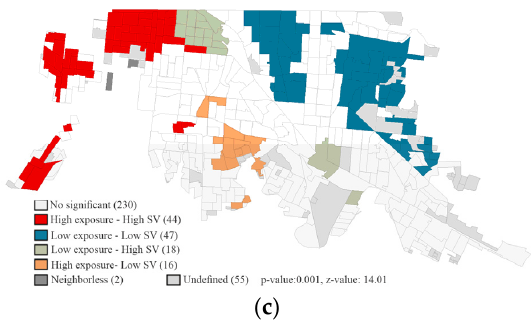
Figure 4. ( a ) Spatial distribution of the socioeconomic status (SES) index. The values in parentheses represent the range by standard deviation and the number of AGEBs for each category. ( b ) Local spatial autocorrelation for the socially vulnerable population. Data from 2010 Census. ( c ) Bivariate local Moran’s Index for spatial autocorrelation between PM 10 exposure and social vulnerability (SV).